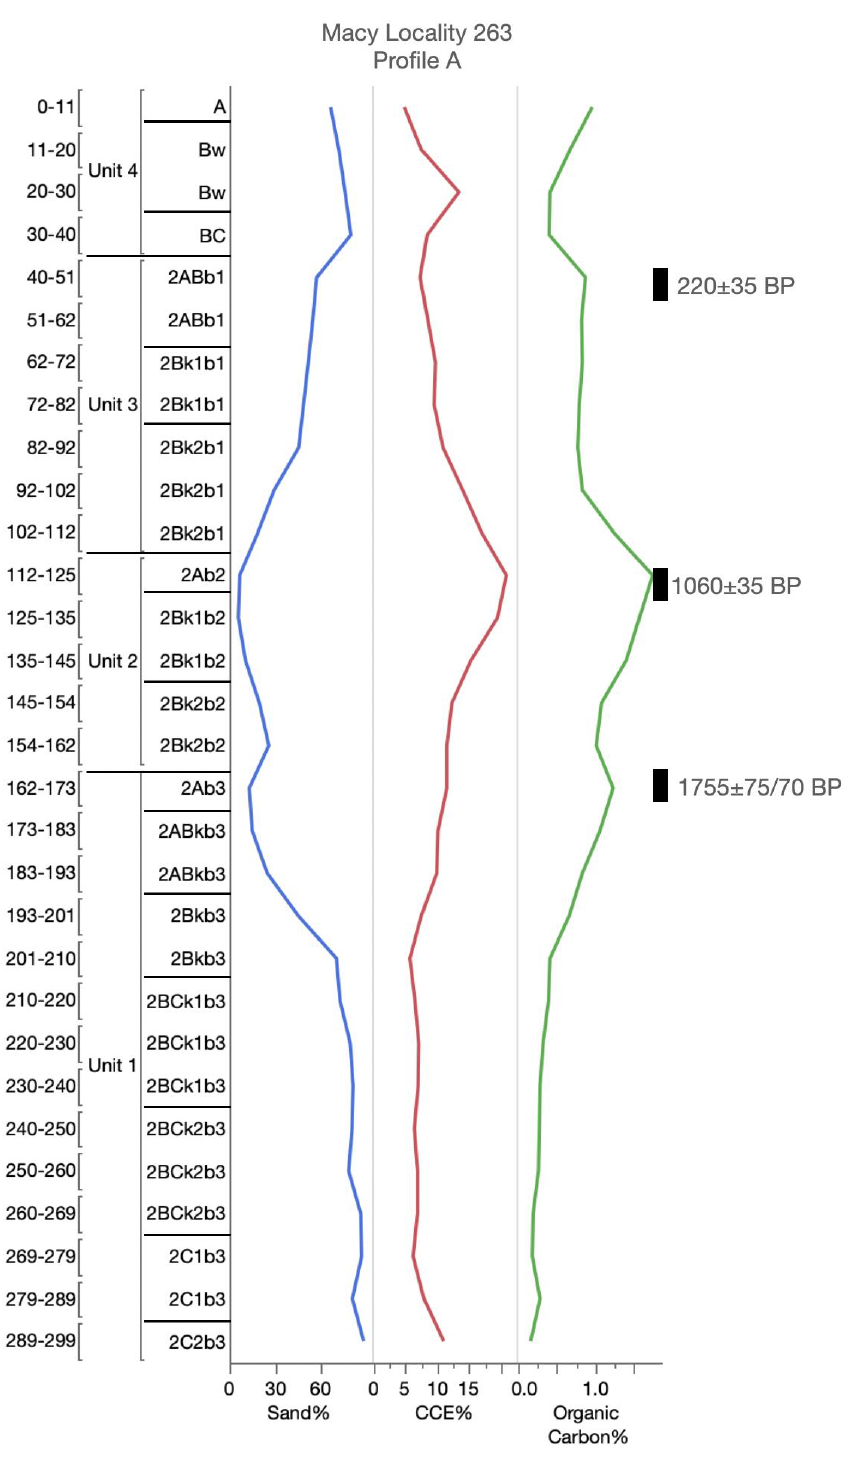
Figure A8. Accepted radiocarbon ages and soil and sediment analysis at Macy Locality 263, Profile A — Post research area, northwest, Texas. CCE = calcium carbonate equivalence.